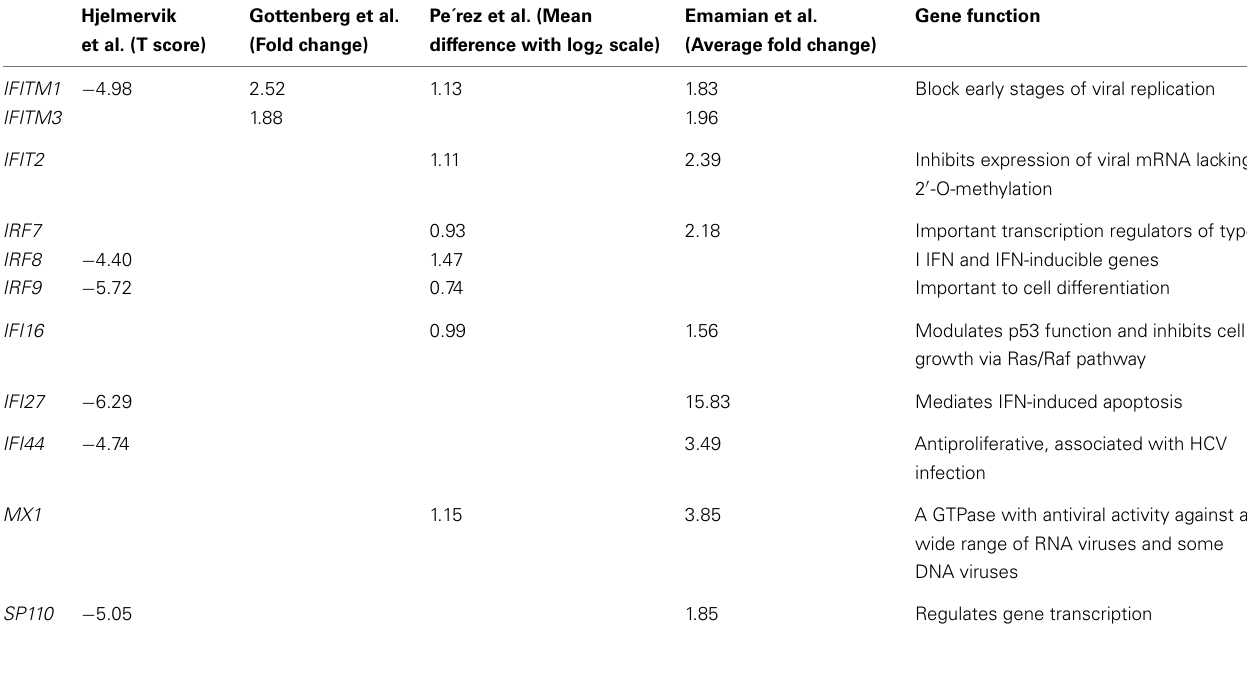
Table 1 | Differentially expressed IFN-inducible genes found in common from the gene expression profiling studies in SS.